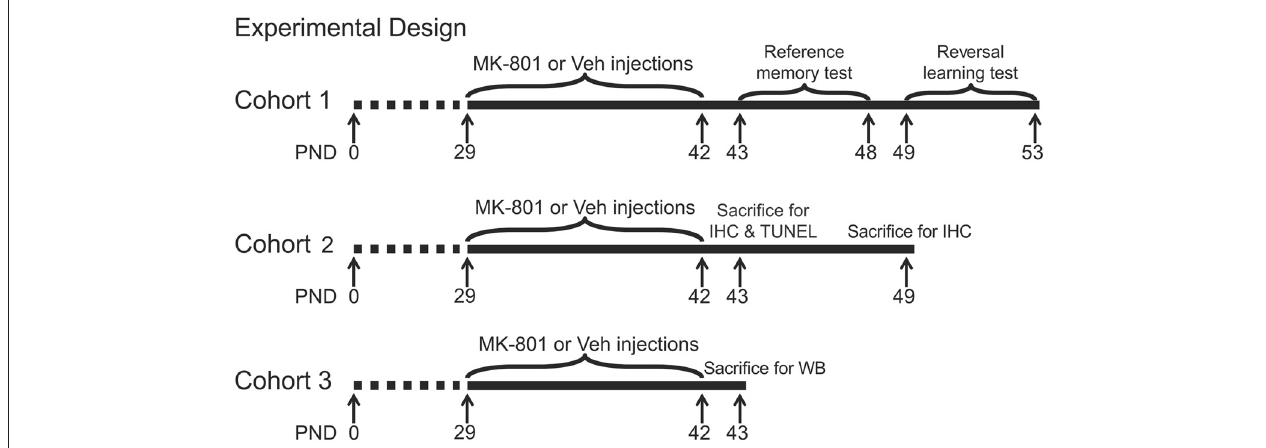
FIGURE 1 | Experimental timelines of behavioral and neurochemical procedures in three animal cohorts. PND, postnatal day; IHC, immunohistochemistry; TUNEL, terminal deoxynucleotidyl transferase-mediated UTP nick end labeling; WB, western